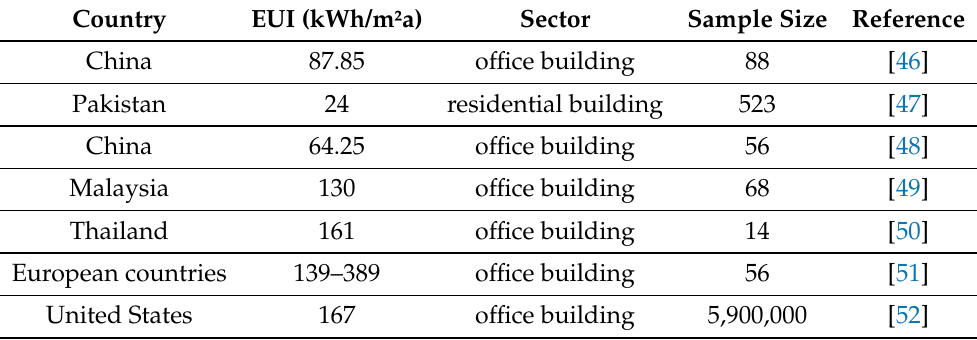
Table 1. EUI of buildings in different countries. Country